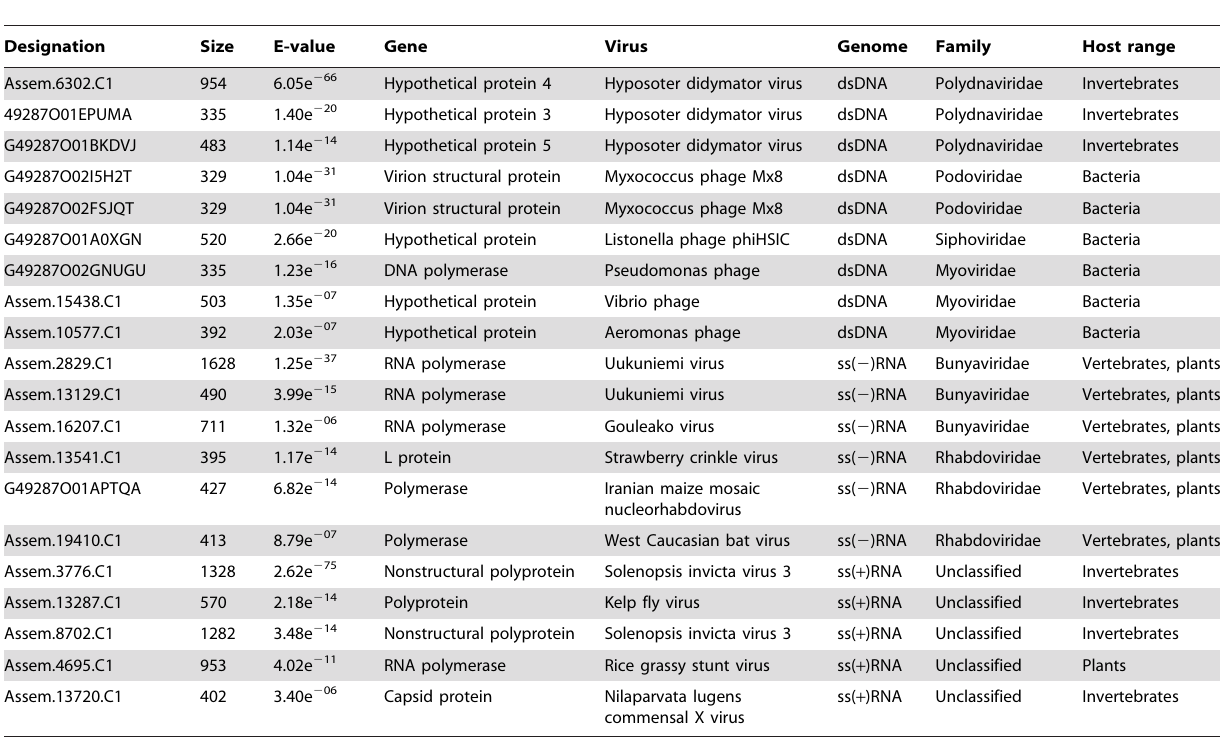
Table 2. N. pubens transcriptome sequences yielding a significant ( # 1e 2 4 ) expectation score from BLAST analysis and exhibiting viral identity.